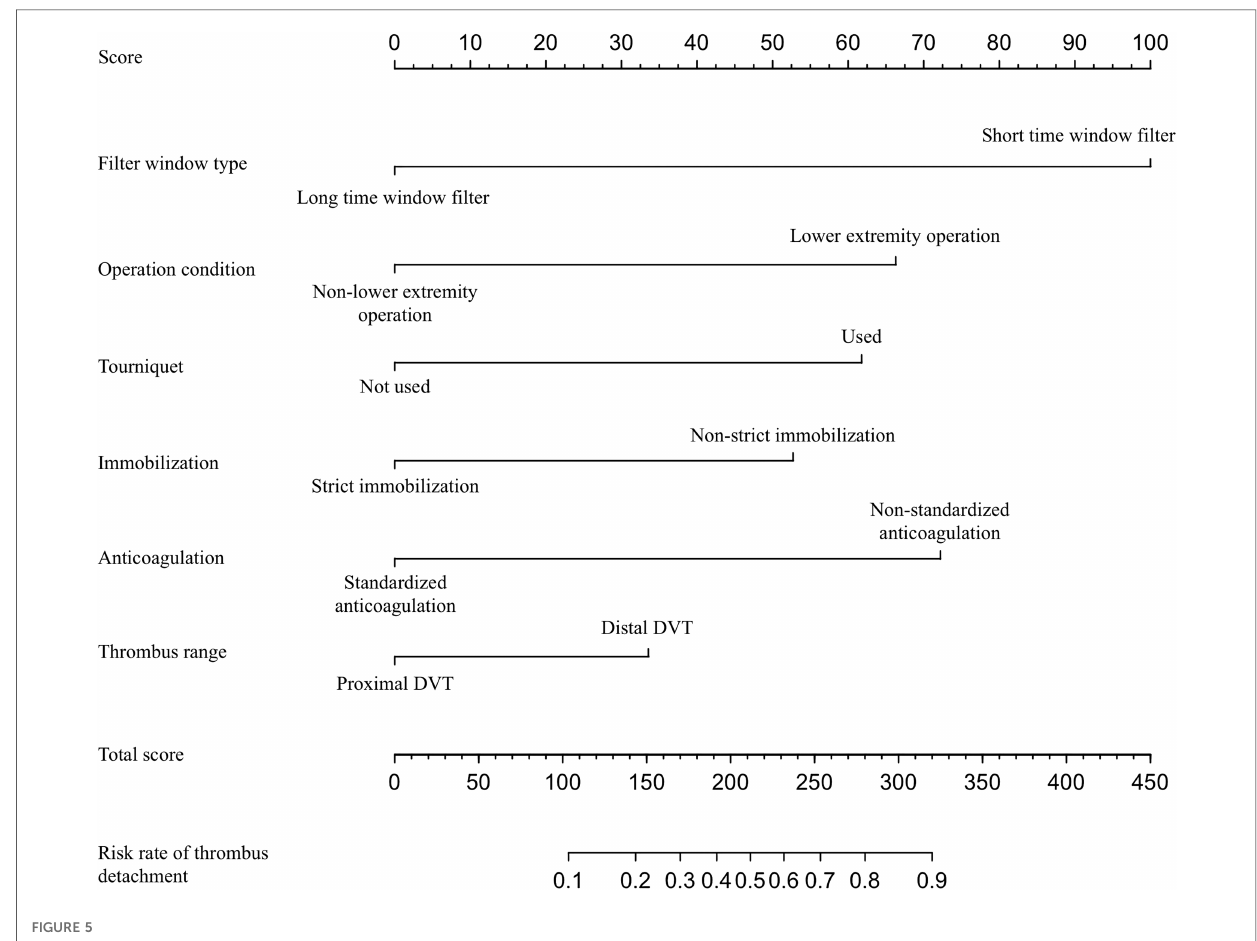
FIGURE 5 Clinical impact curve of nomogram